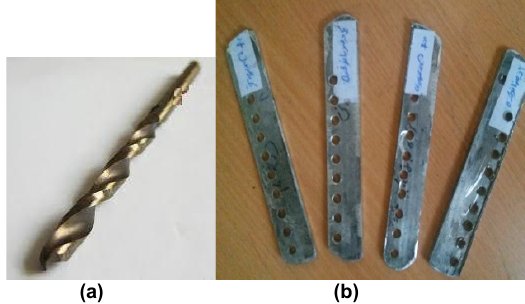
Figure 5. (a) The cutting tool (twist HSS drill coated by cobalt) and(b) Drilled specimens.